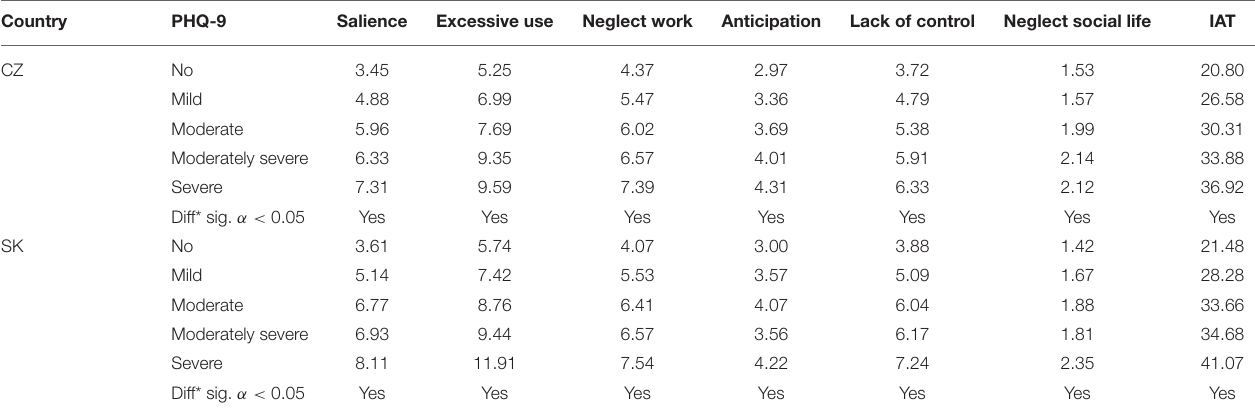
TABLE 9 | Mean values of the IAT and its subscales in the classification by severity of depressive symptoms. Country